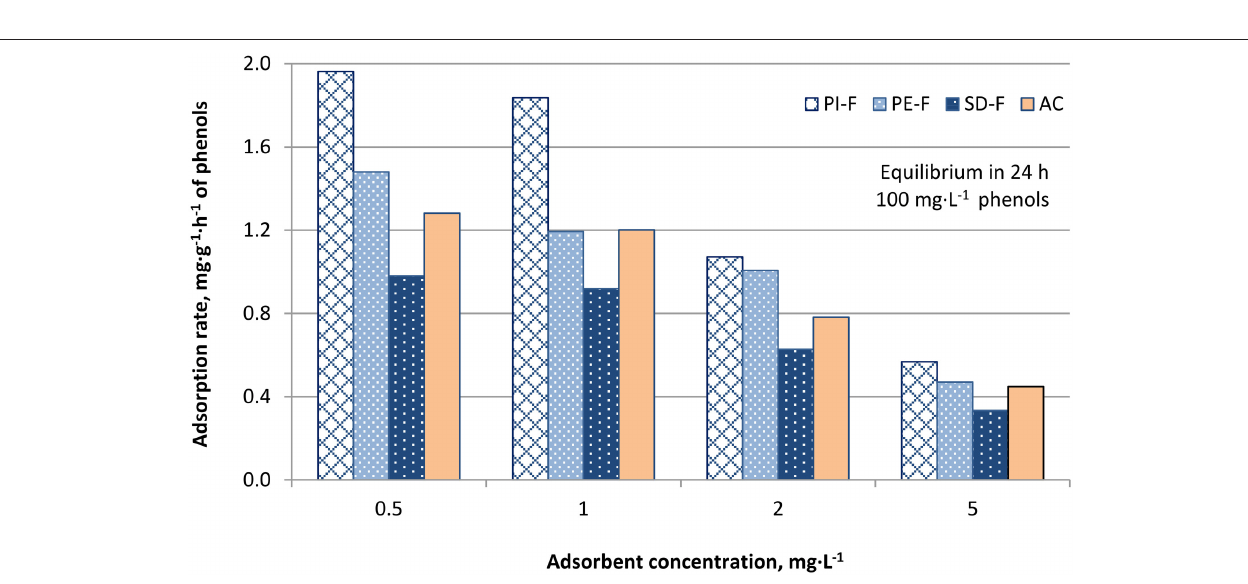
FIGURE 5 | Adsorption rates, mg · g − 1 · h − 1 , of phenols on biochars PI-K, PE-K, and SD-K for adsorbent concentration 0.5, 1, 2, and 5 g · L − 1 (AC: activated carbon, used as reference adsorbent).